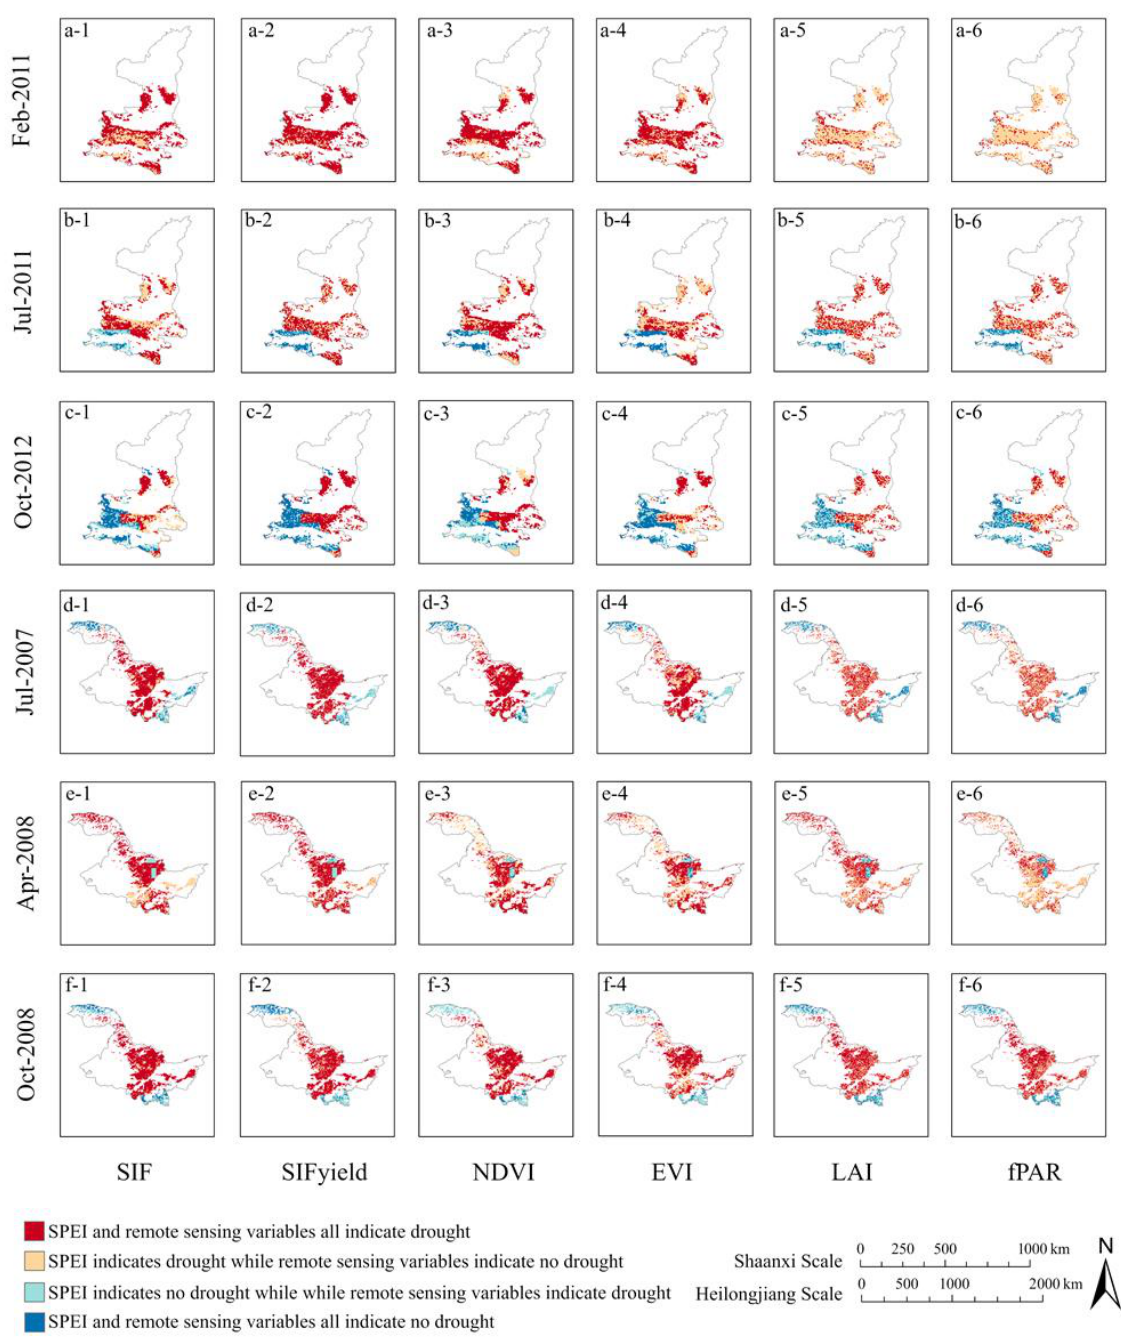
Figure 7. ( a1 – a6 ) The spatial distribution of standardized anomalies of SIF, SIFyield, NDVI, EVI, LAI, fPAR in the early drought period in Shaanxi province, respectively ( b1 – b6 ). The spatial distribution of standardized anomalies of SIF, SIFyield, NDVI, EVI, LAI, and fPAR in the middle drought period in Shaanxi province, respectively ( c1 – c6 ). The spatial distribution of standardized anomalies of SIF, SIFyield, NDVI, EVI, LAI, and fPAR in the late drought period in Shaanxi province, respectively ( d1 – d6 ). The spatial distribution of standardized anomalies of SIF, SIFyield, NDVI, EVI, LAI, and fPAR in the early drought period in Heilongjiang province, respectively ( e1 – e6 ). The spatial distribution of standardized anomalies of SIF, SIFyield, NDVI, EVI, LAI, and fPAR in the middle drought period in Heilongjiang province, respectively ( f1 – f6 ). The spatial distribution of standardized anomalies of SIF, SIFyield, NDVI, EVI, LAI, and fPAR in the late drought period in Heilongjiang province,